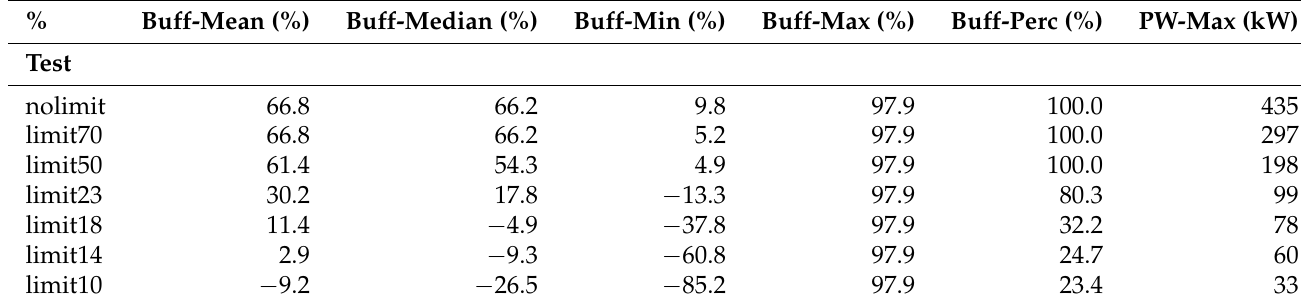
Table 3. Charging buffer values, computed as in Equation (7), are reported in terms of mean, median, standard deviation, minimum value and maximum value over the whole number of charge cycles and EV. The buff-perc term indicates the percentage of EVs that are above the MINSOC value at the end of each charge cycle. The last two columns of the table report the mean and standard deviation of the instant power provided by the power